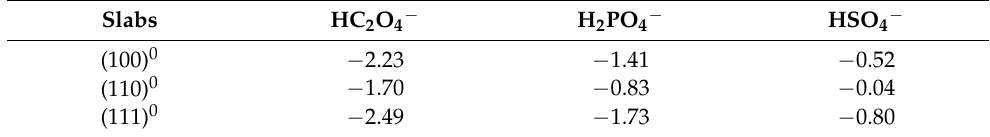
Figure 1. The acid radicals connecting with the adsorbed H 2 O through O–H–O bond: ( a ) the (100), ( b ) the (110), ( c ) the (111) surfaces. Table 3. The E bon (eV) values of acid radicals bonding with the H of adsorbed H 2